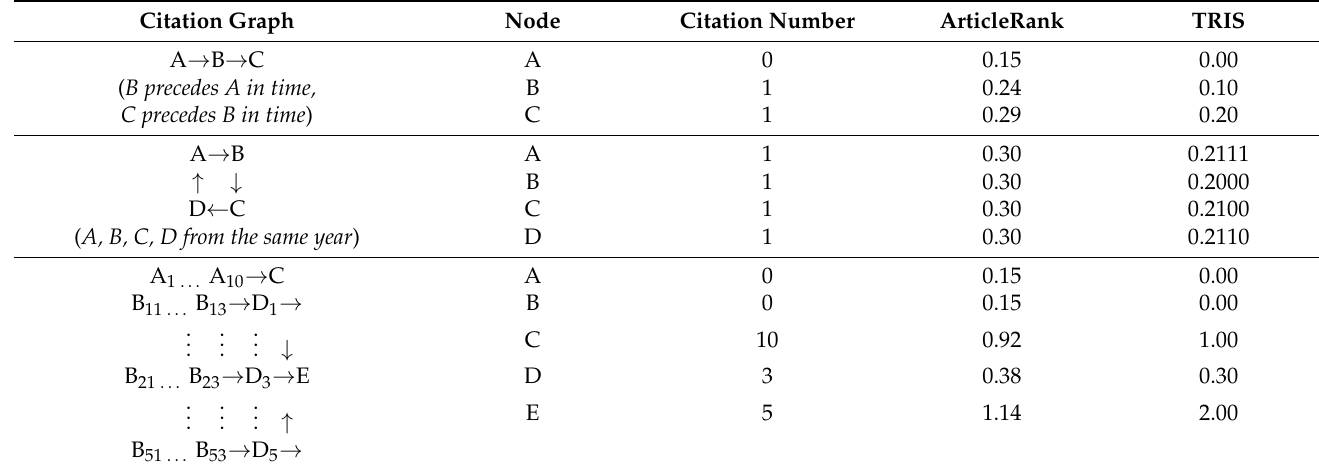
Table 2. Comparison of measurements on artificial